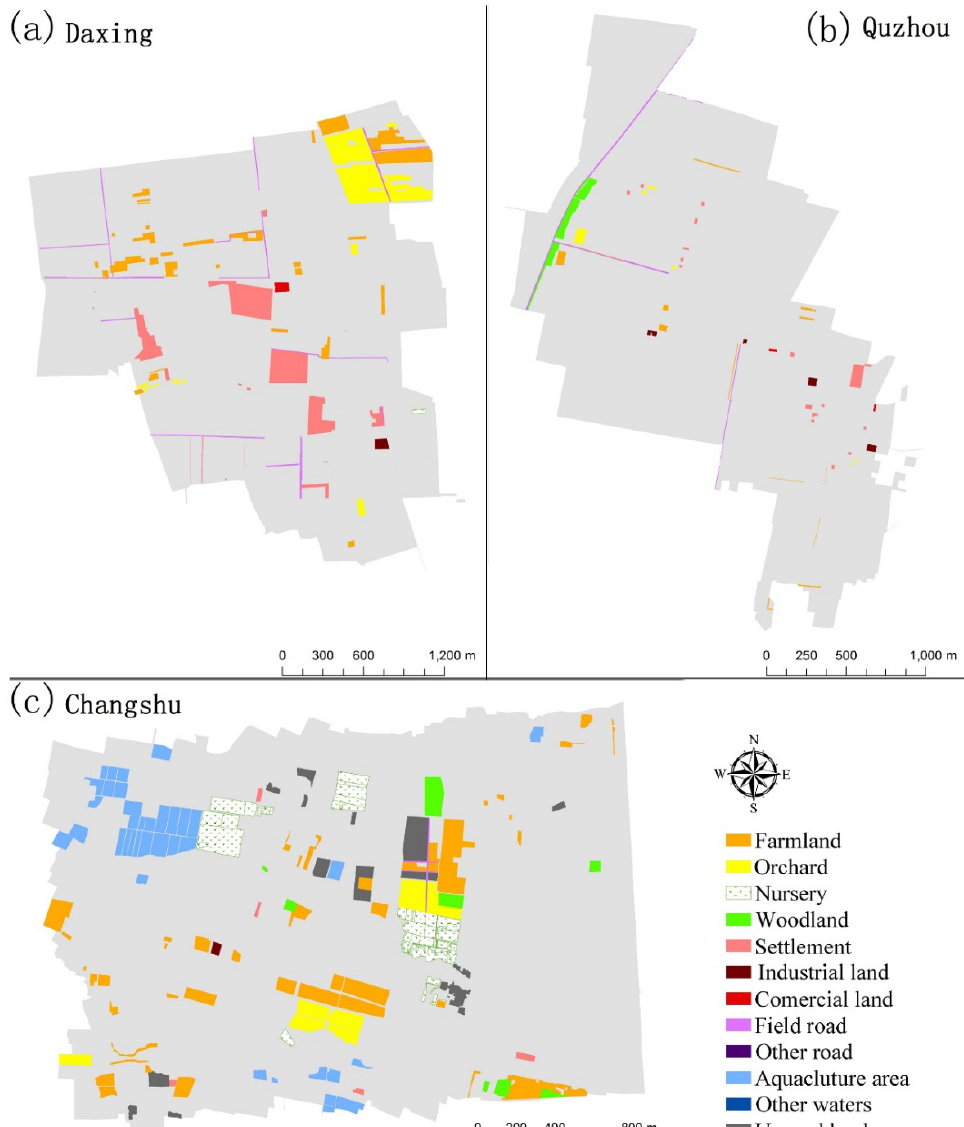
Figure 4. Maps of plots with changed land use these maps present the shape, distribution, and increased land use of changed patches from 2009 to 2012. Each patch showed land use in 2012. ( a ) The changed land use patches map of Daxing; ( b ) the changed land use patches map of Quzhou; ( c ) the changed land use patches map of Changshu